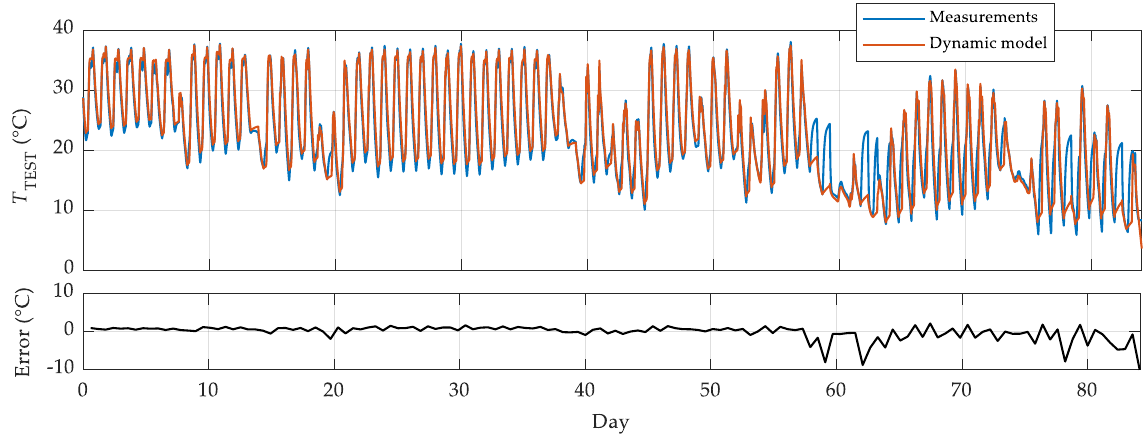
Figure 11. Validation of a dynamic model of a TEST with measurements for 83 days.